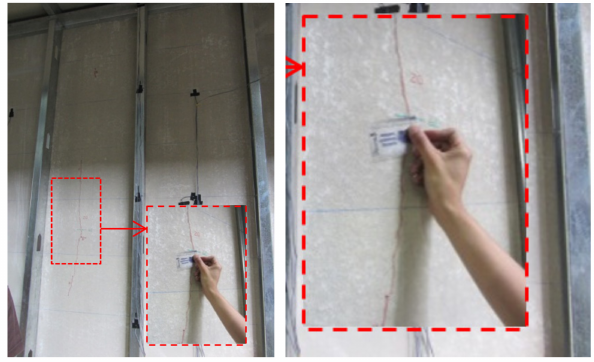
Figure 21. Crack G2 on the east face of wall